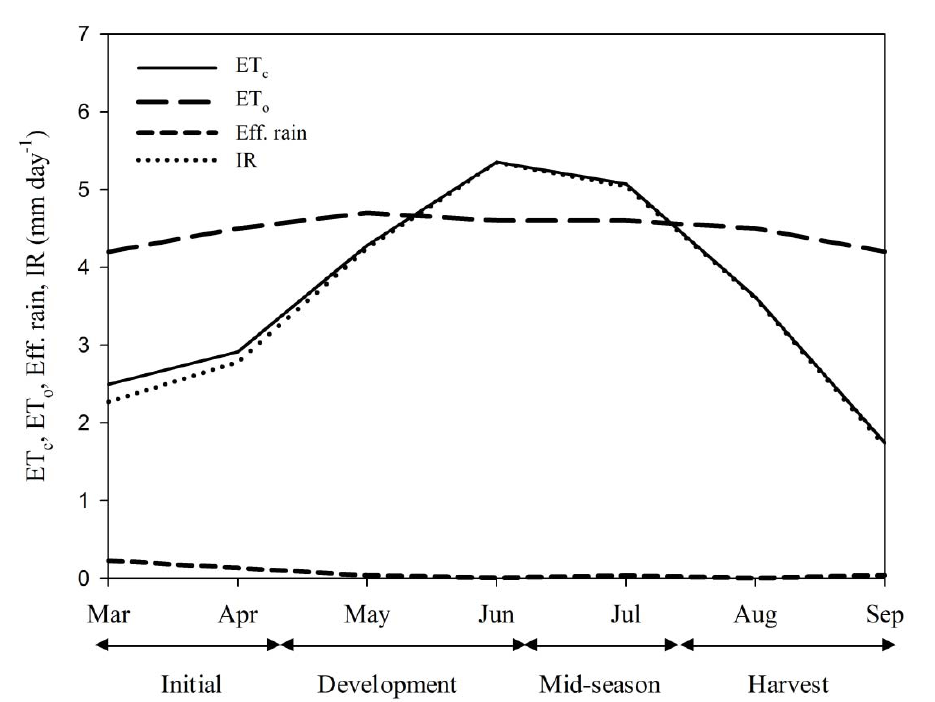
Figure 1. Daily crop evapotranspiration ( ET effective rainfall (Eff. Rain) and basic irrigation requirements ( IR ) of jatropha in the reference climate during one growing period (March–September).